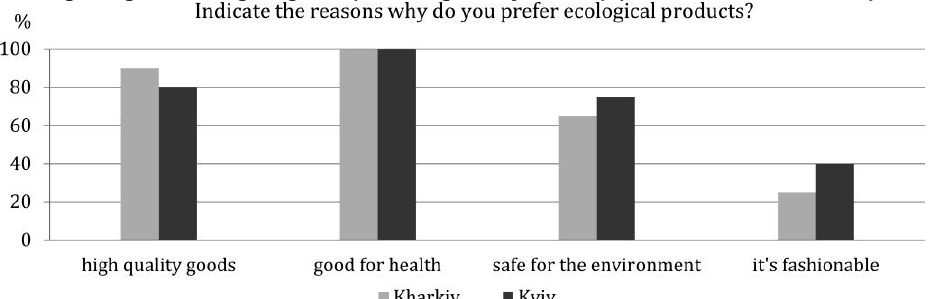
Fig. 4. Signs of ecological goods (according to respondents) (Source: author's research)